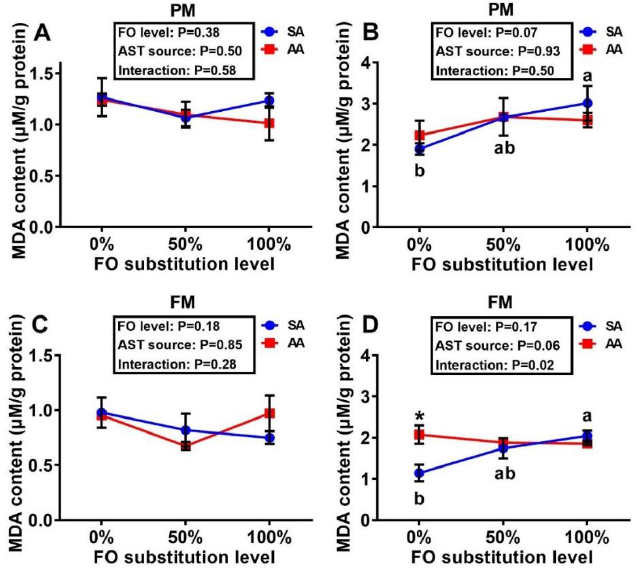
Figure 3. Effects of dietary fish oil substitution by DHA-rich microalgae and source of astaxanthin on MDA concentrations in the muscle (fillet, A , C ) and liver ( B , D ) of juvenile rainbow trout fed the plant meal- (PM, A , B ) and fishmeal (FM, C , D )-based diets. Means labelled with different letters [lowercase (a, b), synthetic astaxanthin (SA) groups] are different between various fish oil substitutions ( p < 0.05). Asterisks ( * ) indicate differences between the SA and AA groups ( p < 0.05) at the same level of FO substitution. The absence of different letters (a, b) or asterisks ( * ) between means indicates no significant differences. MDA: malondialdehyde. FO: fish oil. AST: astaxanthin.